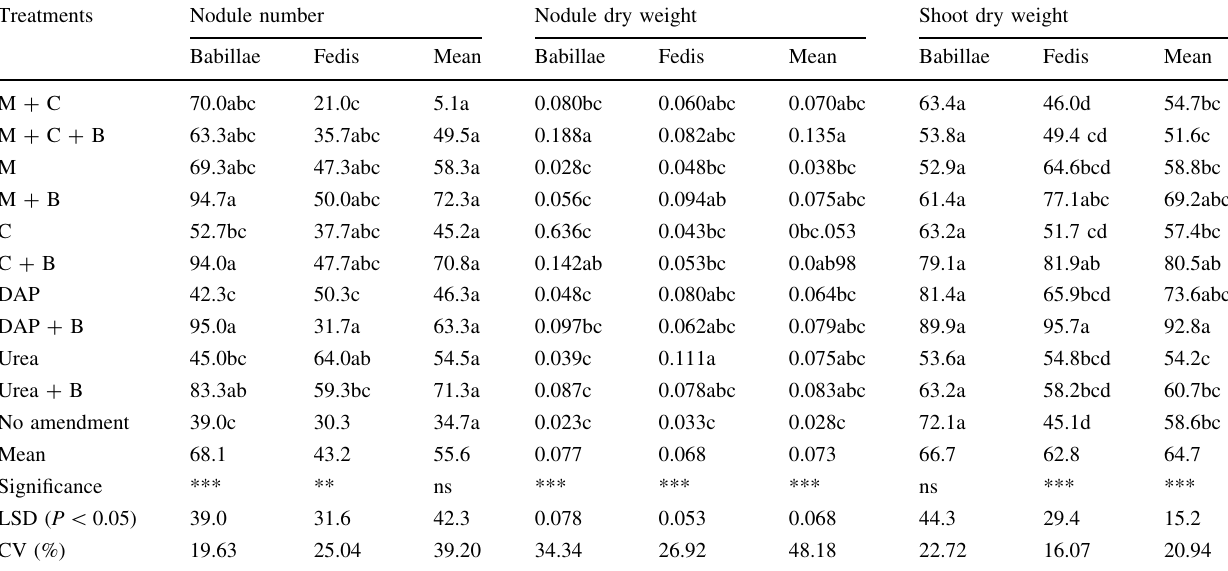
Treatments Nodule